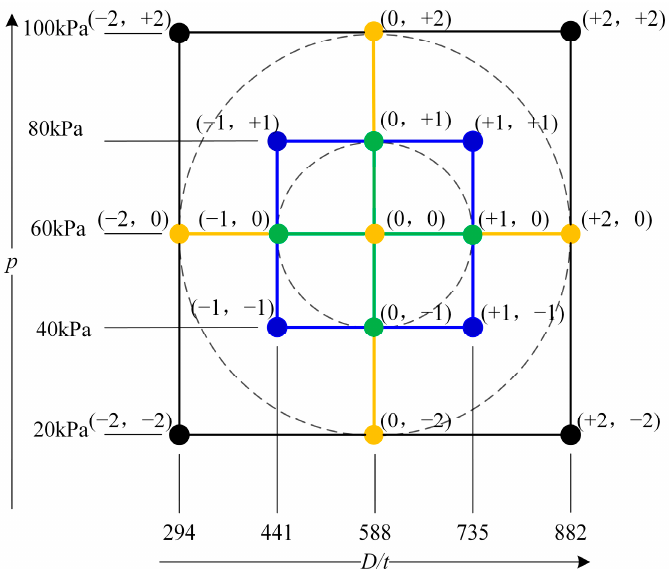
Figure 8. Coded scheme of the design of the experiment for the plan of simulations.